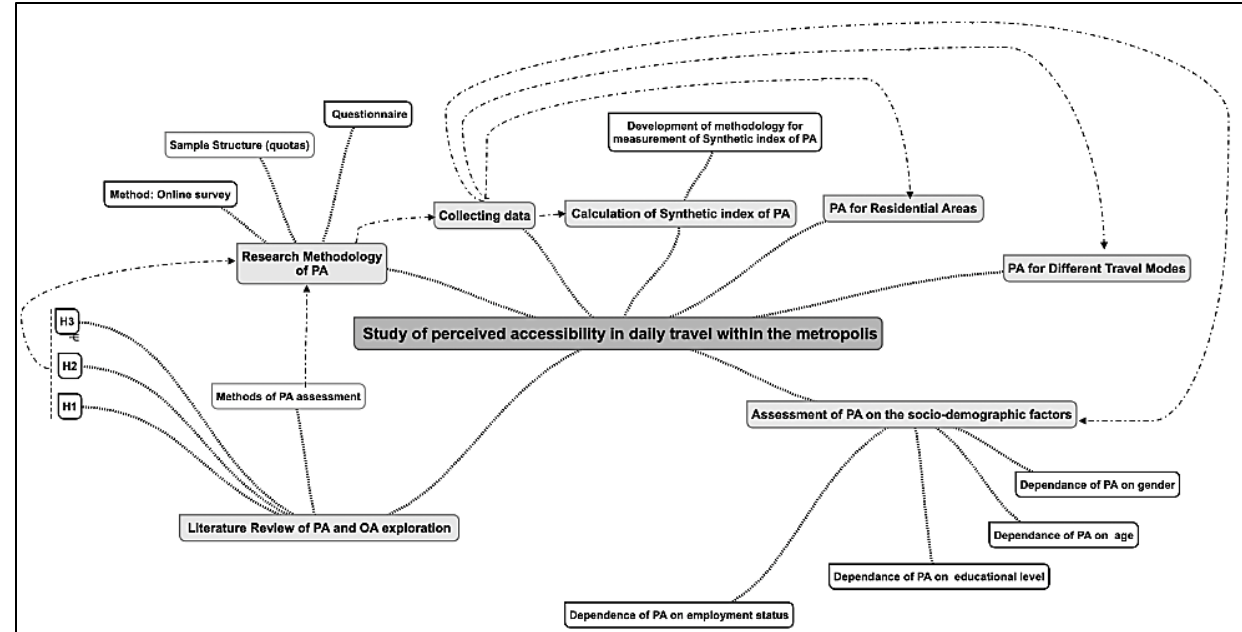
Figure 2. Research methodology